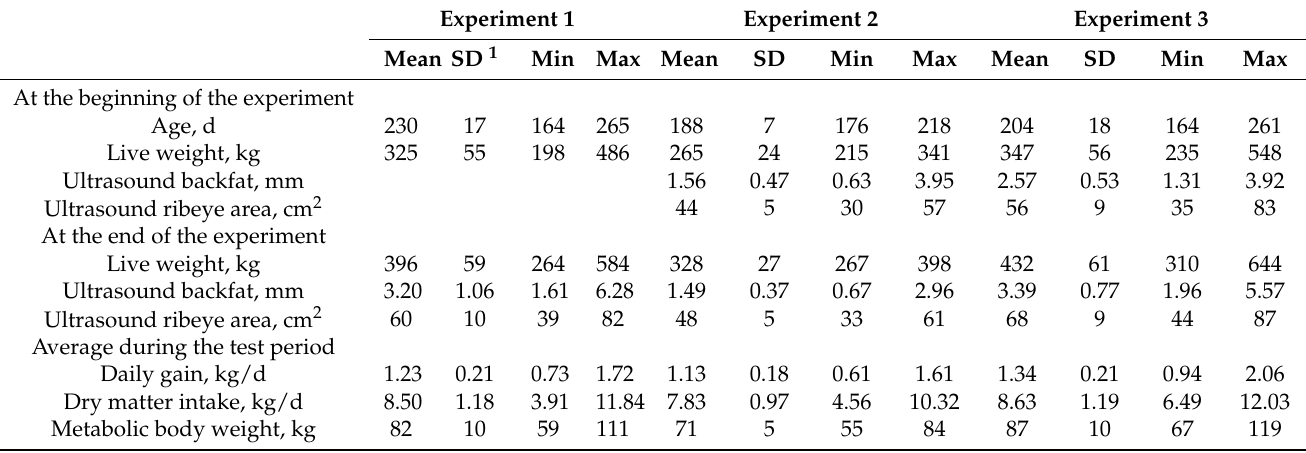
Table 4. Age, live weight, ultrasound traits, growth, dry matter intake, and metabolic body weight of the bulls in three